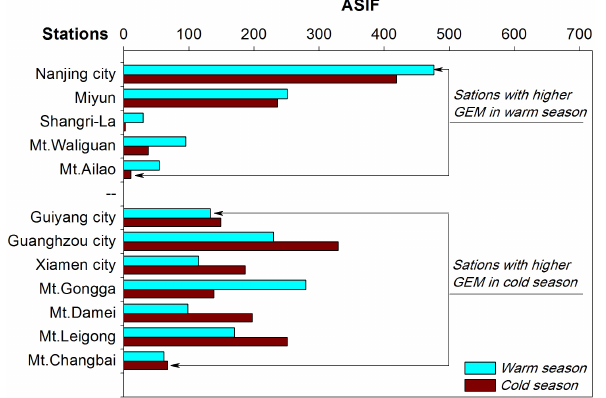
Figure 9. Annual mean GEM concentrations at Mt. Changbai in northeastern Figure 7. Dimensionless anthropogenic Hg 0 sources impacted fac- tor (ASIF) at Chinese ground-based stations in cold and warm sea- P N 0 ij × Hg ij sons. ASIF is defined as ASIF = , where N ij is the num- P N ij ber of trajectory endpoints in a 0.5 ◦ × 0.5 ◦ grid cell (i,j) during the sampling period, and Hg 0 is the total anthropogenic Hg 0 emis- ij sions in a 0.5 ◦ × 0.5 ◦ grid cell (i,j). The source region domain con- tains 20 × 20 grid cells at a spatial resolution of 0.5 ◦ × 0.5 ◦ . The ground-based stations (receptors) are located in the center of the domain. The 5-day backward trajectory that ended at a height of ∼ 1000m a.g.l. was utilized for the calculation of ASIF.